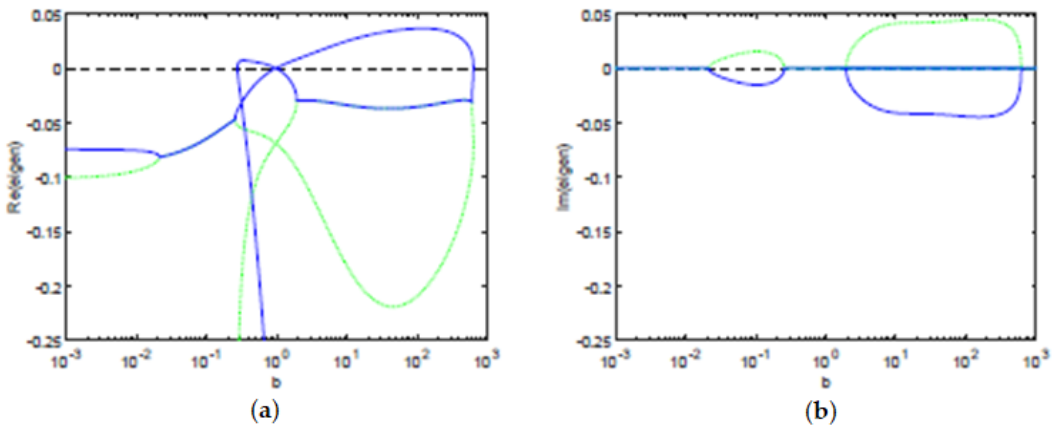
Figure 4. Relation between the eigenvalues ( λ ) with the largest real part (blue line) and the second largest real part (green dashes) with the antigenic stimulation b of T cells, for m = 0.2765. ( a ) the largest real part of the eigenvalues can be positive for b between b L ≈ 2.8 × 10 − 1 and b H ≈ 6.4 × 10 2 ; and that the second largest real part of the eigenvalues is negative. ( b ) the two shown eigenvalues can be complex conjugate for b between ∼ 2.1 × 10 − 2 and ∼ 2.5 × 10 − 2 , and for b between ∼ 1.9 and ∼ 6.1 × 10 2 .